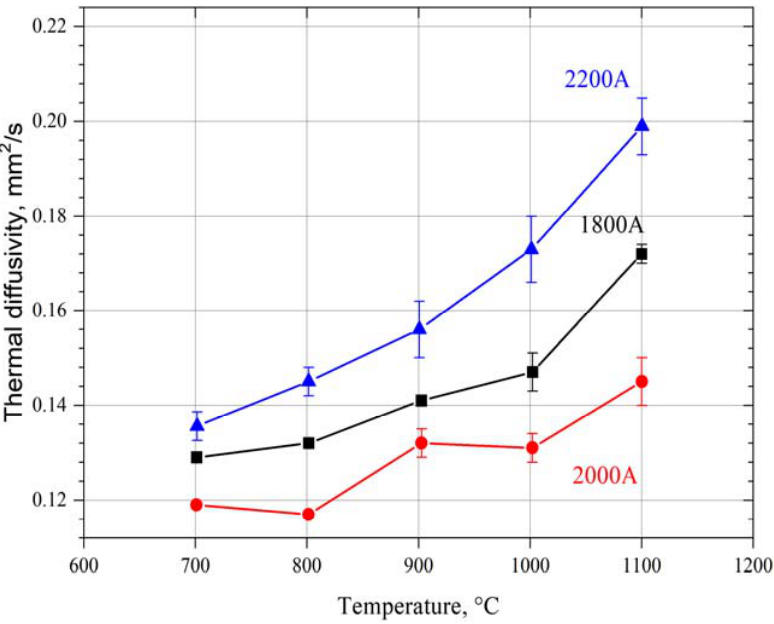
Figure 5. Thermal diffusivity of synthetized Yb 2 Zr 2 O 7 in the reactive PS-PVD process using different power currents in the temperature range 700–1100 °C.